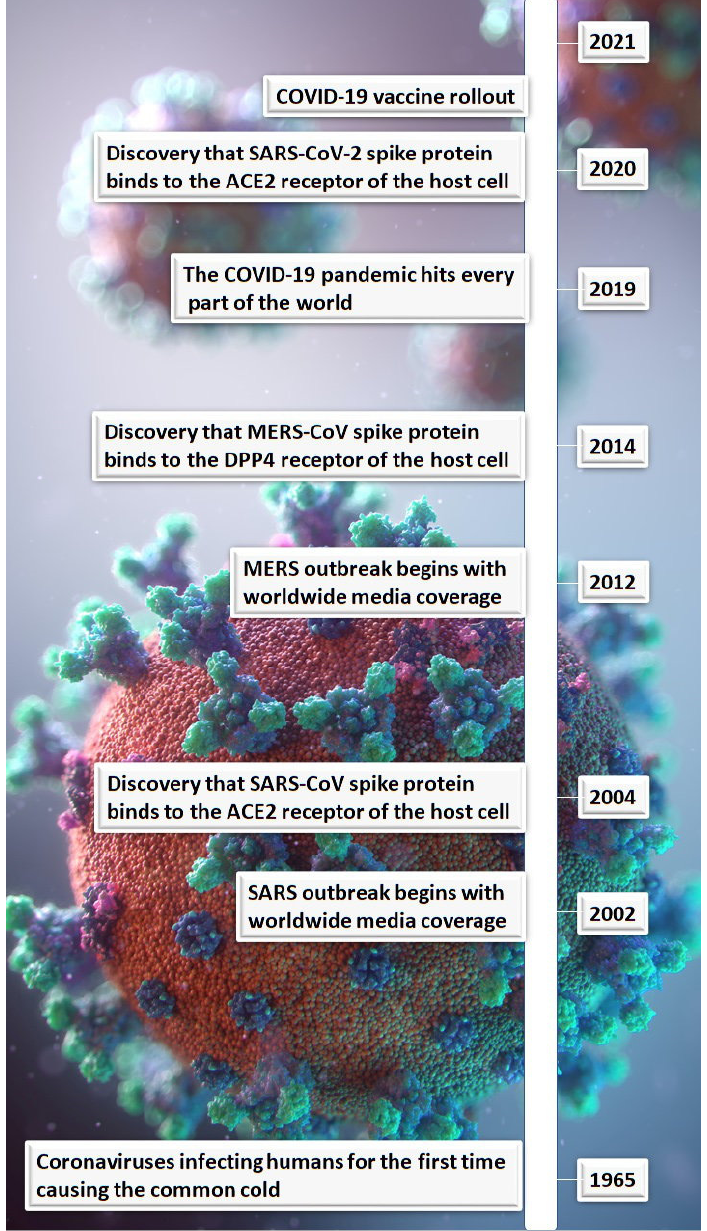
Figure 1. Timeline of coronaviruses and spike protein receptor targets .